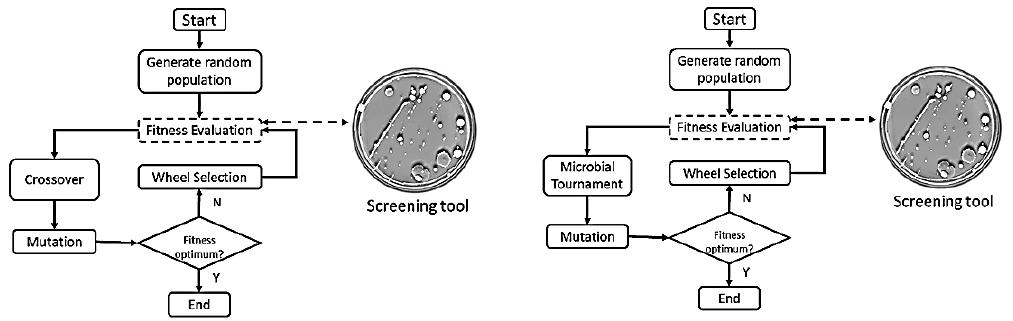
Figure 2. SGA ( left ) and SMGA ( right ) evolutionary algorithms.